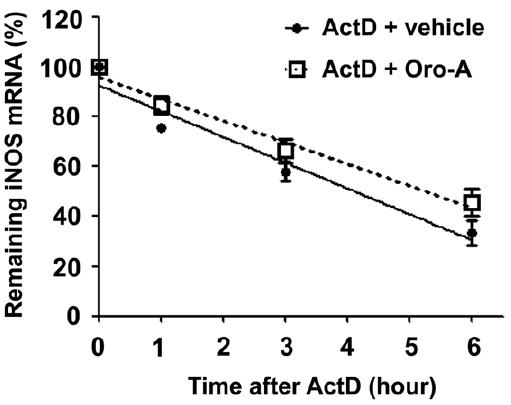
Figure 3. Effects of oroxylin A on cell viability. BV-2 cells (5 6 10 4 cells/well) were exposed to LPS (100 ng/ml) and oroxylin A (Oro-A, 10– 100 m M) for 24 hours. Subsequently, the cell viability was determined by MTT assay. Results are expressed as percent of vehicle-treated group and are means 6 SEM from three independent experiments in triplicates.